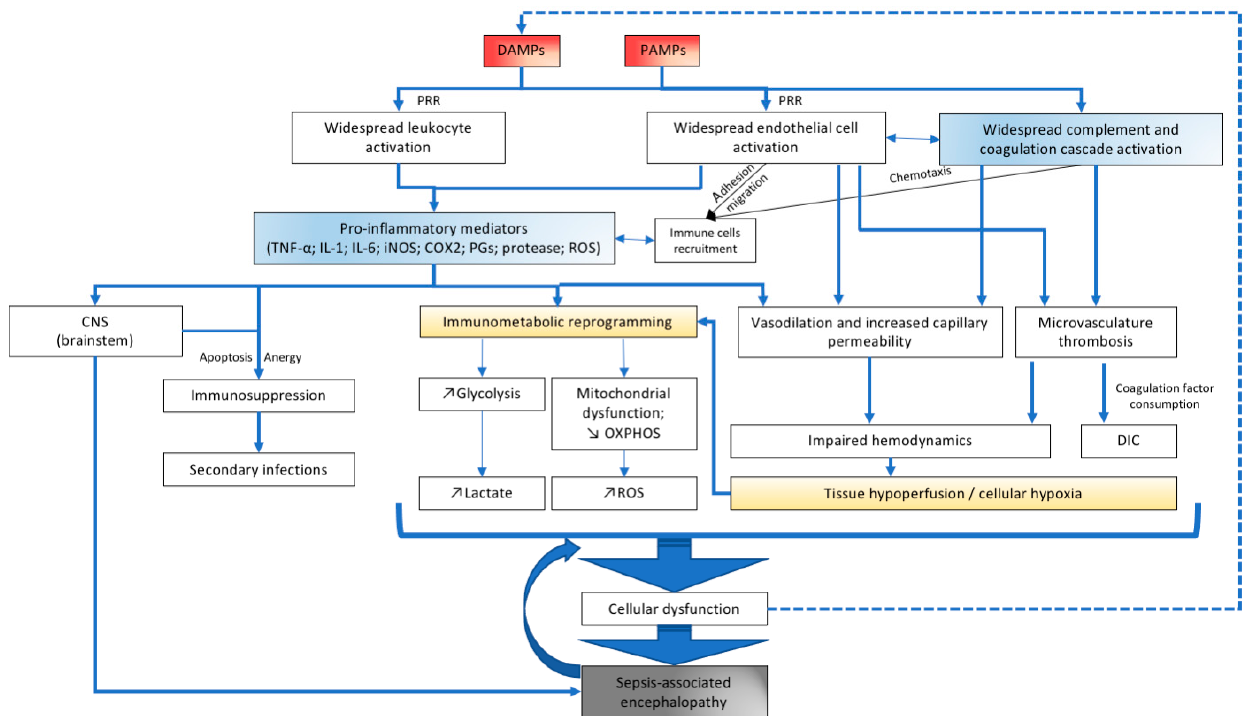
Figure 1. Overview of the pathophysiology of sepsis-associated encephalopathy. DAMPs (damage-associated molecular patterns), PAMPs (pathogen-associated molecular patterns), PRR (pattern recognition receptors), TNF (tumor necrosis factor), IL-1, IL-6 (interleukins 1 and 6), iNOS (inducible nitric oxide synthase), COX2 (cyclooxygenase 2), PGs (prostaglandins), ROS (reactive oxygen species), CNS (central nervous system), OXPHOS (oxidative phosphorylation), DIC (disseminated intravascular coagulation).